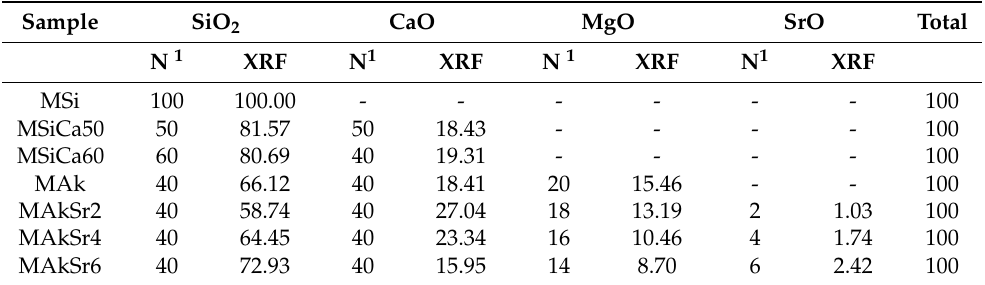
Table 2. Chemical composition of the synthesized MSNs as detected by XRF in mol%.